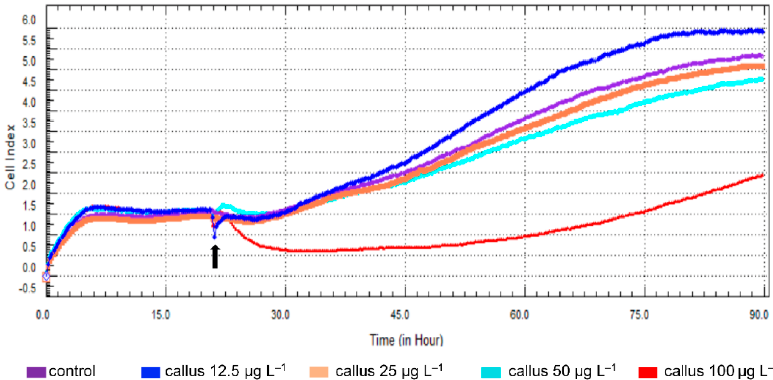
Figure 4. The real-time, label-free monitoring of the callus extracts effects of on CRTL-2522 human skin fibroblast proliferation using the xCELLigance system. A representative graph is shown. CRTL-2522 cells were treated with various concentrations of callus extract. The cell index value was monitored in real-time for 72 h (black arrow indicates the time of callus extract